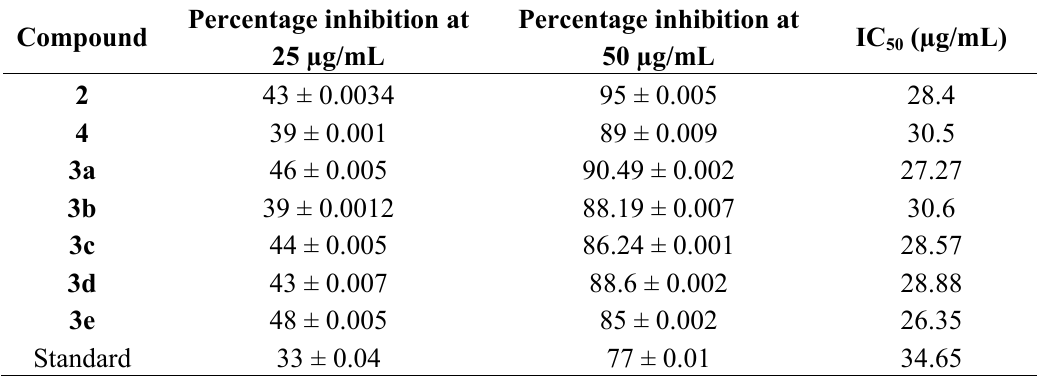
Table 2. Urease inhibition studies of